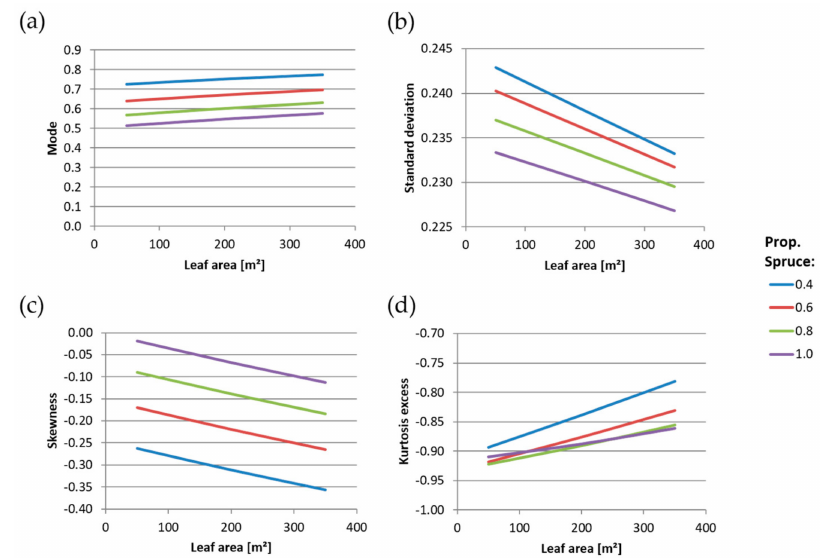
Figure 7. Statistics of the leaf area distribution of spruce, calculated from the parameters p and q as estimated from Equation (11) with coe ffi cients from Table 5. ( a ): Mode (Equation (7)), ( b ): Standard deviation (Equation (8)), ( c ): Skewness (Equation (9)) and ( d ): Kurtosis excess (Equation (10)).